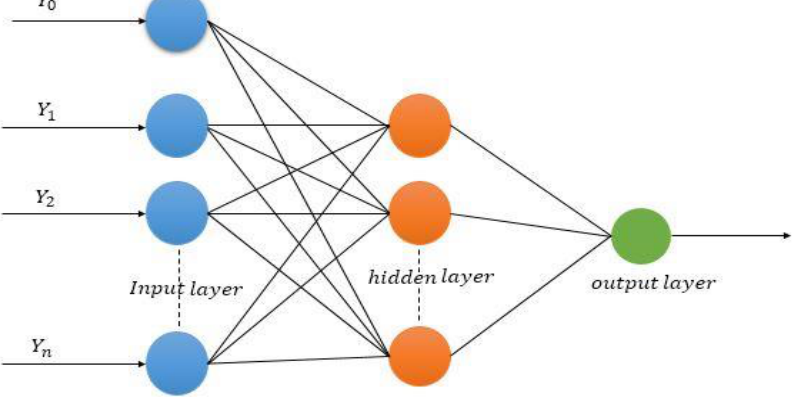
Figure 3. Generic neural network composed of three layers.